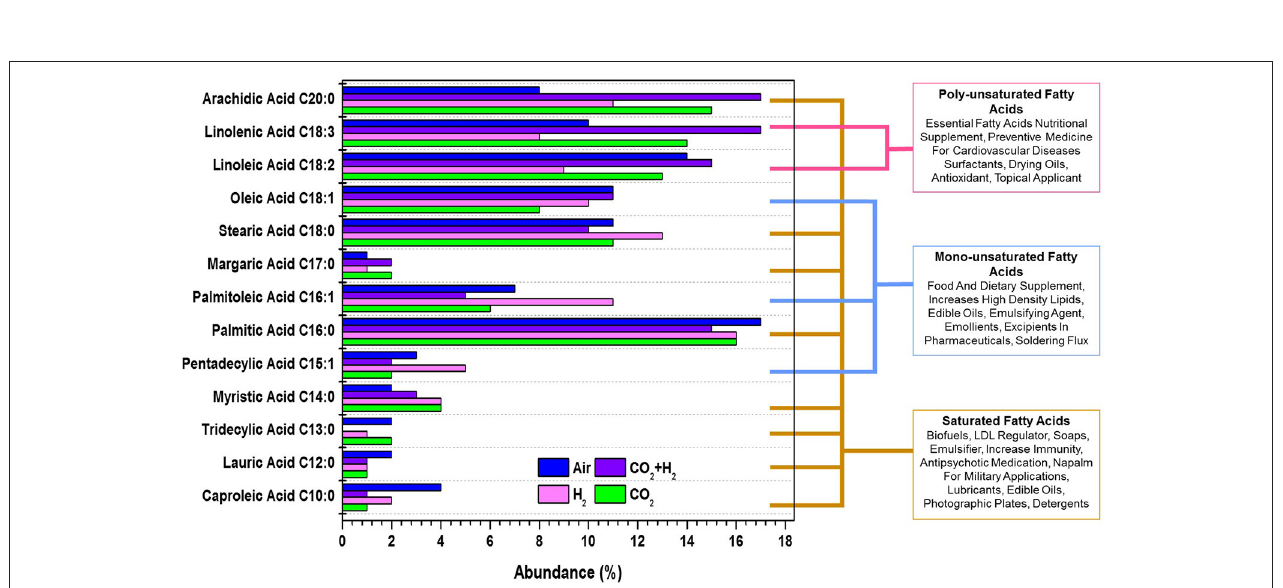
FIGURE 5 | Fatty acid methyl esters profile showing the variations in the photofuels and bioactive compounds synthesis abundance with the function of varying gas compositions is presented for all experimental variations.